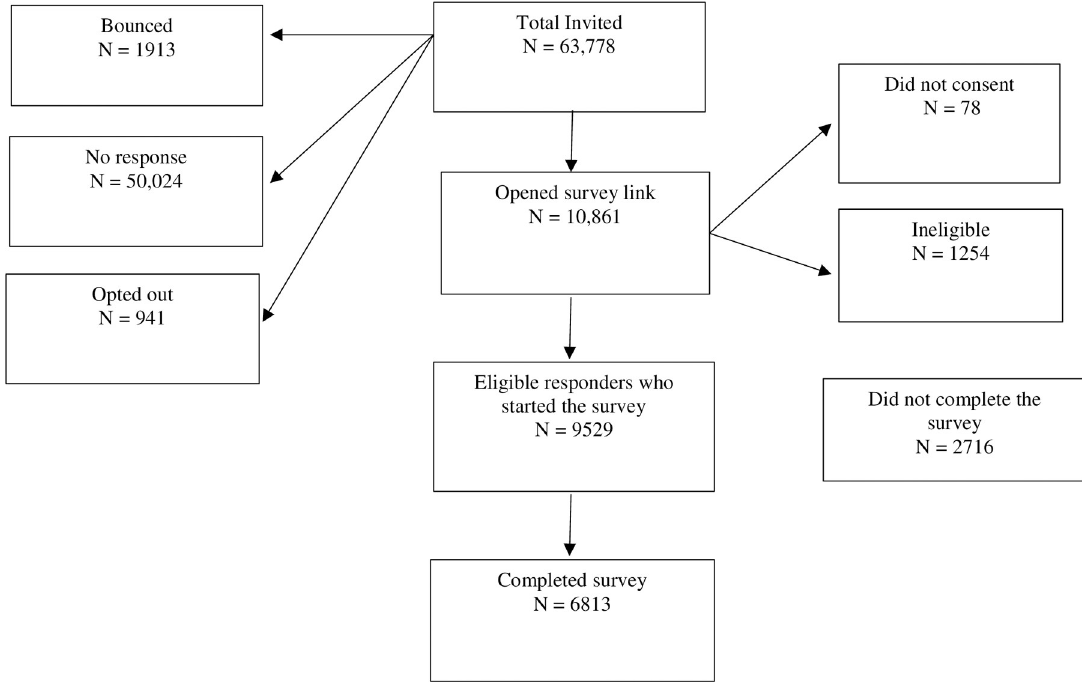
Fig 1. Flow chart of the